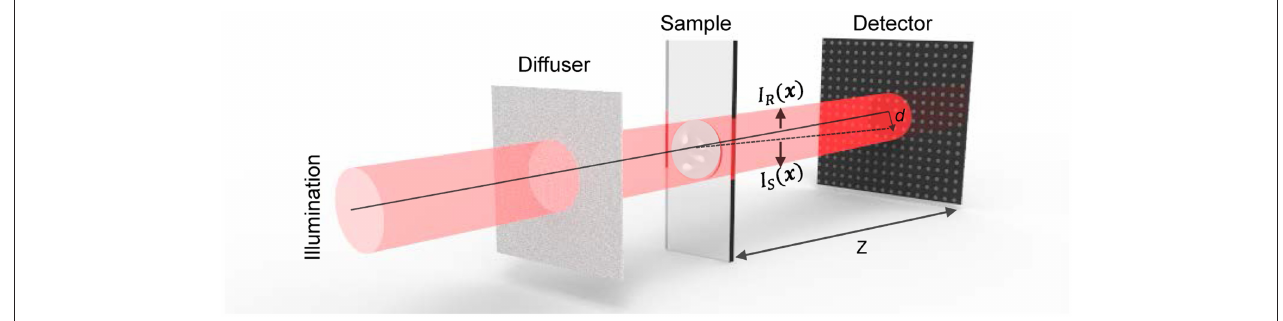
FIGURE 1 | Geometric setup for GFST (geometric-flow based X-ray speckle